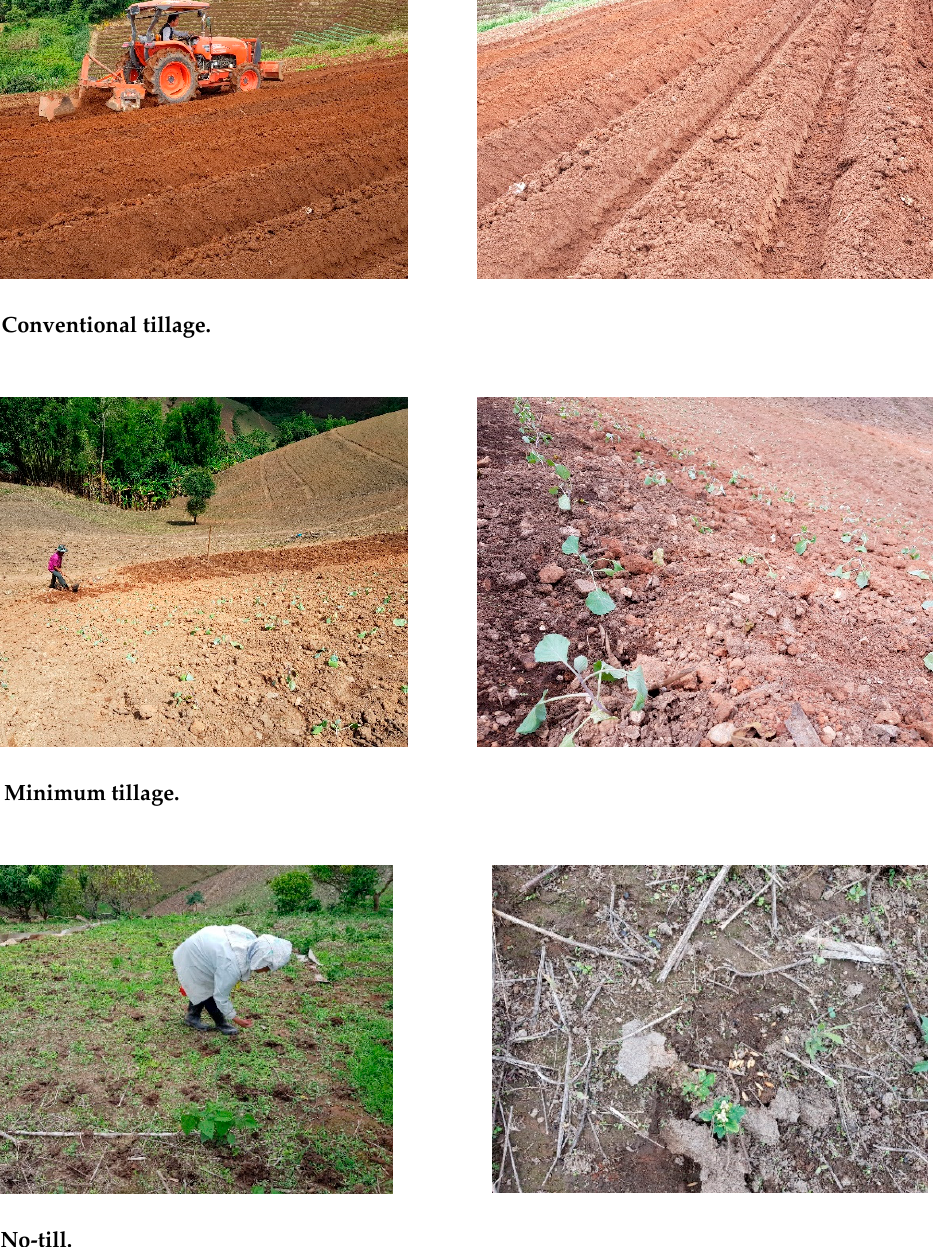
Figure 2. Tillage methods in highland agricultural areas: ( a ) Conventional tillage; ( b ) Minimum ( c ) tillage; ( c ) No-till.